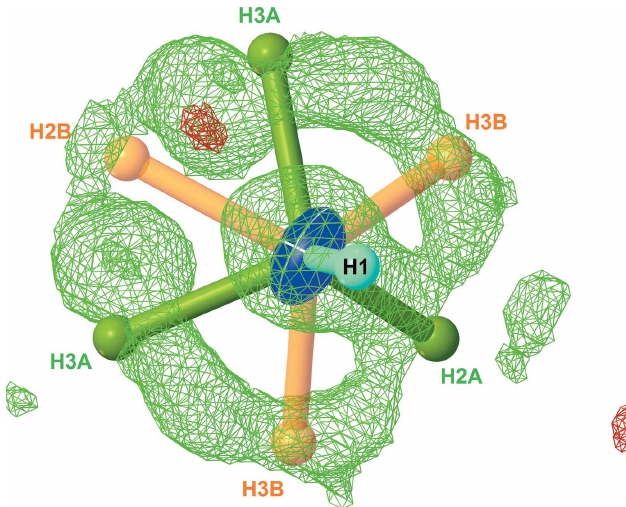
Figure 2 Difference electron-density map in the vicinity of the N-atom site calculated on the basis of a model including N1 and H1 atoms ( R 1 = 0.0183, wR 2 = 0.0420). The difference map is plotted at the 0.18 e (cid:7) A˚ (cid:7) 3 level with a resolution of 0.05 A˚ (Dolomanov et al. , 2009). At this level, only positive residuals are observed (green wire), corresponding essentially to the N—H (cid:3) bond and missing H atoms. Positions for all H atoms in the final refinement ( R 1 = 0.0163, wR 2 = 0.0296) are superimposed on the calculated difference map, showing the fit between the experimental data and the proposed